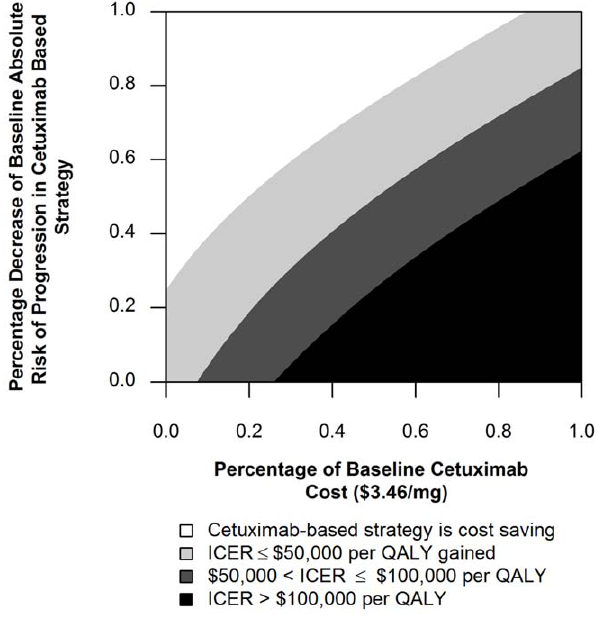
Figure 2. Sensitivity of the ICER to the cost of cetuximab per mg and the risk of progression in the cetuximab based strategy.